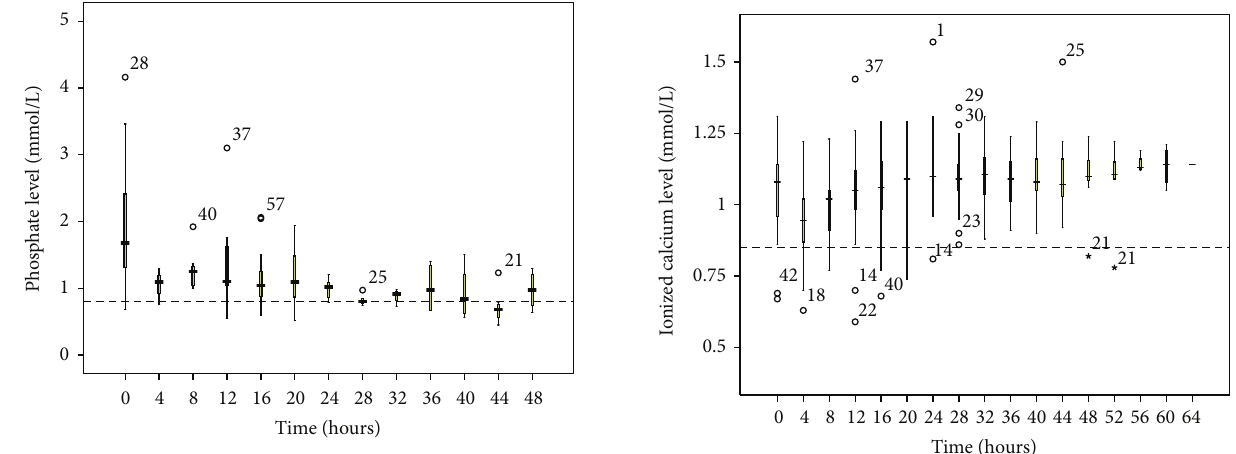
Figure 9: Ionized calcium changes over time during citrate CRRT. Standard box plot in which the horizontal line represents the median,thethicklinerepresentstheinterquartilerange,andthethin line represents the maximum and minimum values. The circular dots represent the